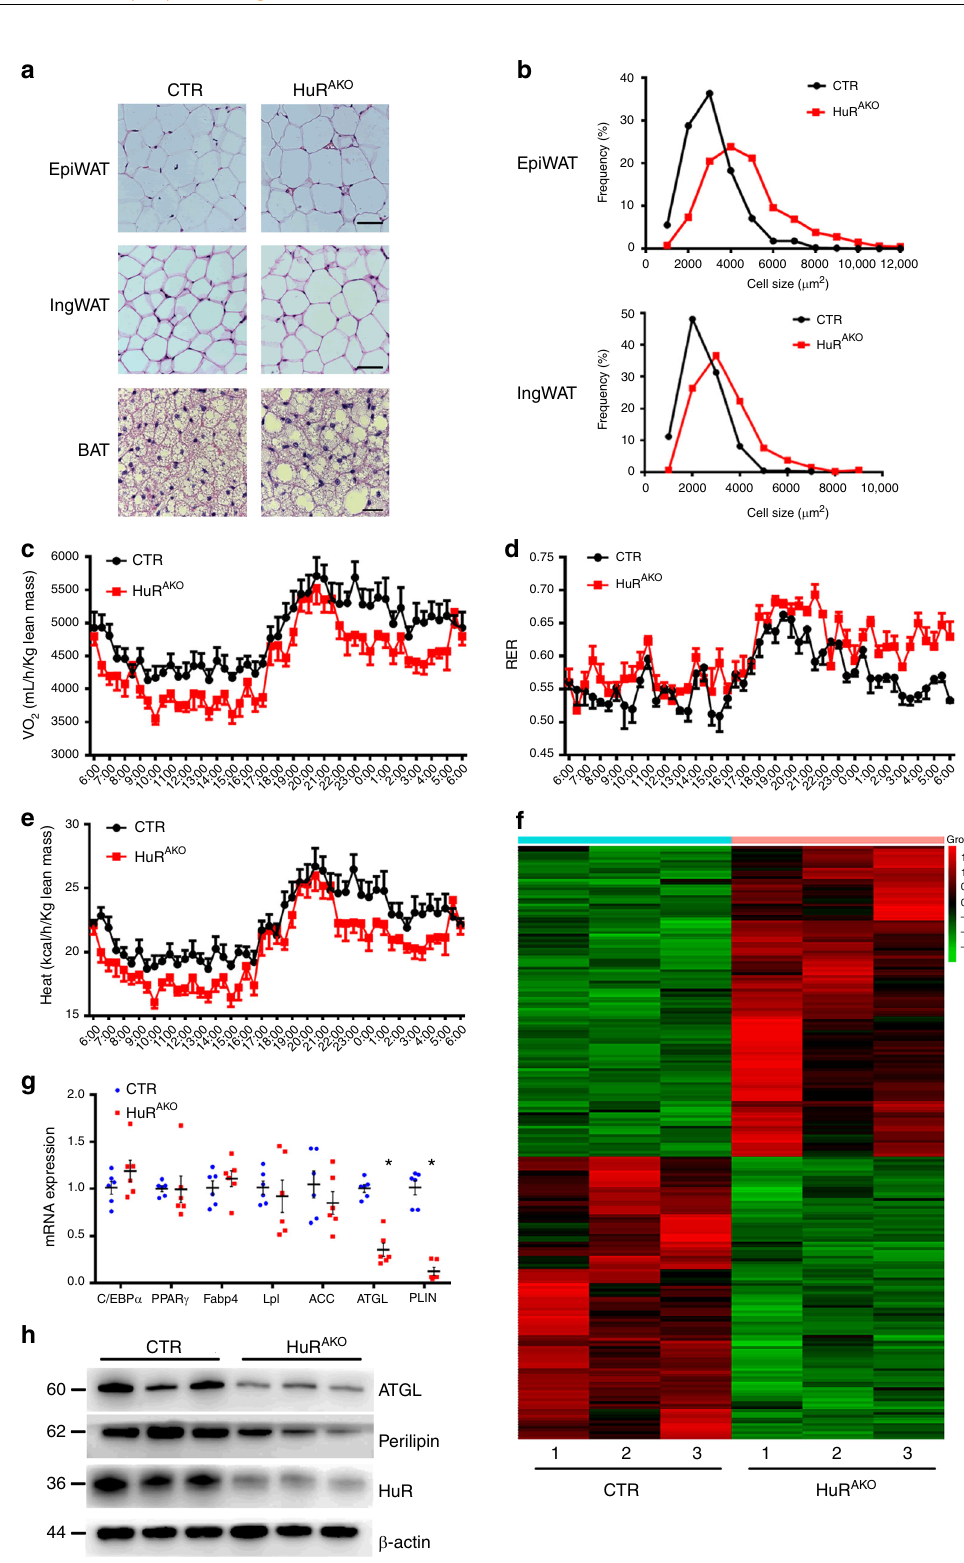
Fig. 3 HuR ablation results in adipocyte hypertrophy. a Representative H&E images of epiWAT, ingWAT and BAT in HFD-fed control and HuR AKO mice. Scale bar 50 μ m for WAT and 20 μ m for BAT. b Quanti fi cation of adipocyte diameter. Total 300 – 350 cells per group were measured ( n = 5). c – e Metabolism studies of control and HuR AKO mice fed an HFD: oxygen consumption ( c ), respiratory exchange ratio (RER) ( d ) and heat production ( e ) ( n = 4). f Heatmap represents genes with >1.5-fold upregulation or >1.5-fold downregulation in HuR -de fi cient adipose tissue compared with control. g qPCR analysis of mRNA levels of genes related to adipogenesis, adipocyte differentiation and lipolysis in epididymal adipose tissue from control and HuR AKO mice fed an HFD ( n = 6), *comparison of HuR AKO vs. control. h Protein expression of ATGL and PLIN with HuR ablation in adipose tissue ( n = 3). Data are represented as mean ± SEM. Signi fi cance was determined by Student ’ s t test analysis, * P < 0.05. Source data are provided as a Source Data fi